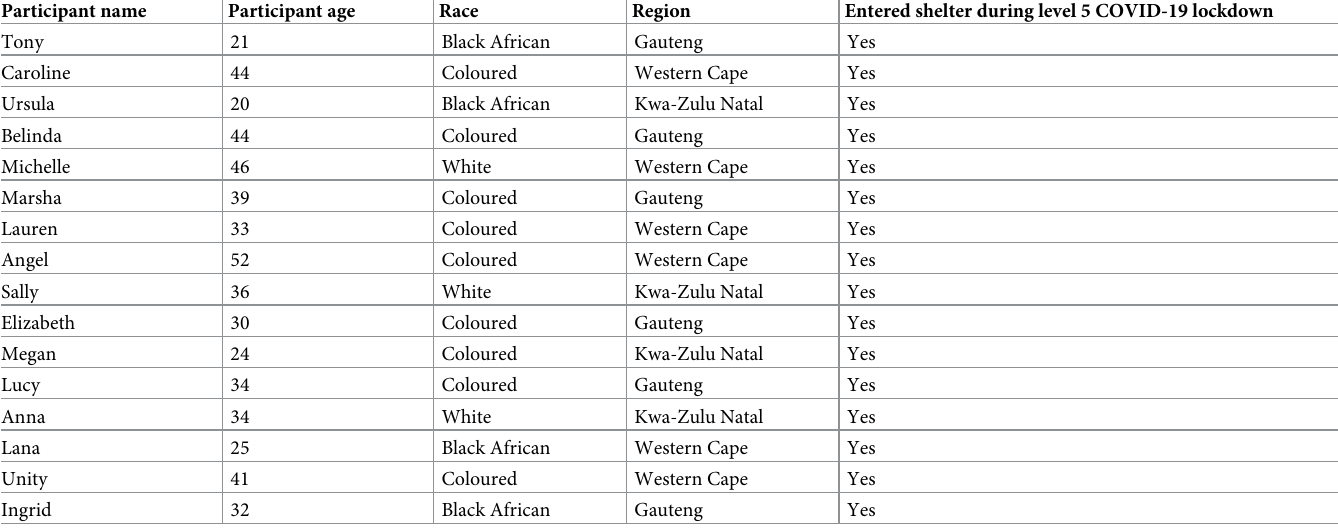
Table 2. Participant